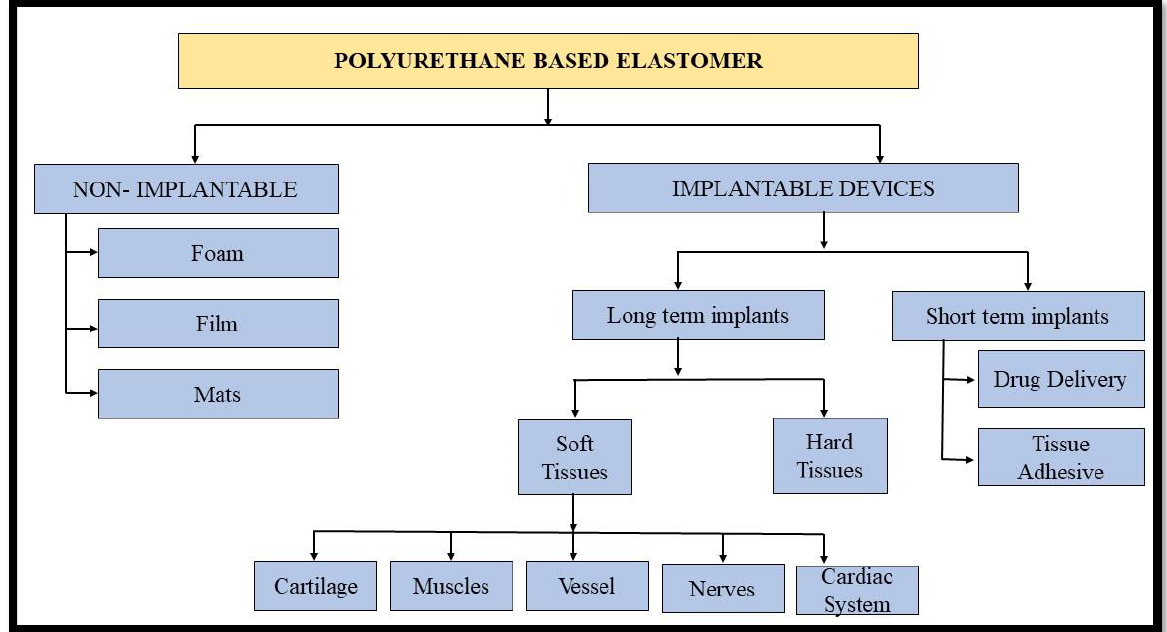
Figure 8. Classification of Polyurethane Elastomers in Biomedical Field.